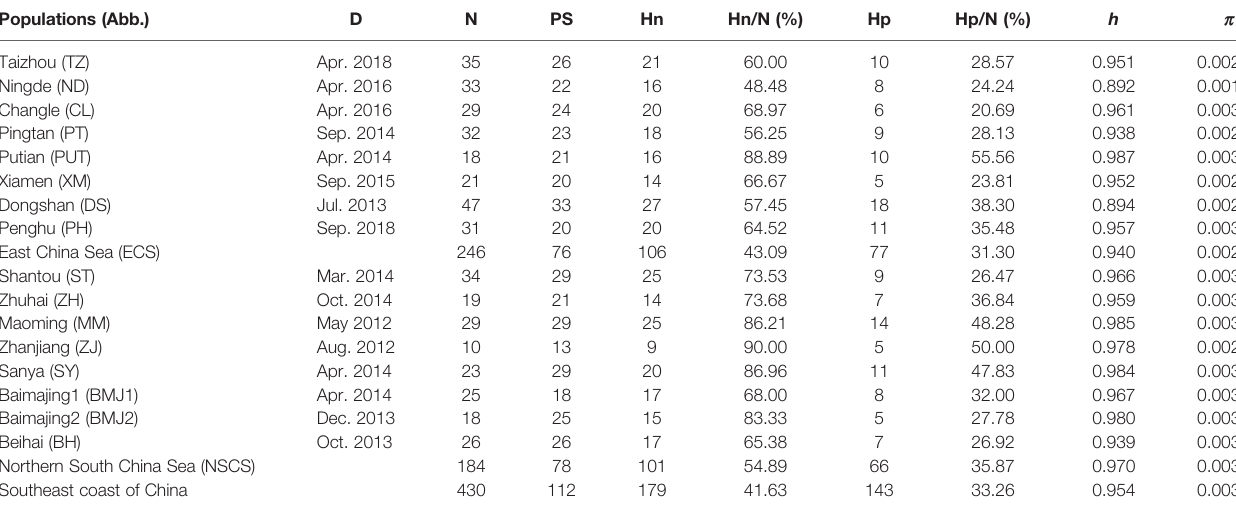
TABLE 1 | Sampling information and genetic diversity indices of Decapterus maruadsi based on concatenated sequences (Cyt b + CR). Populations